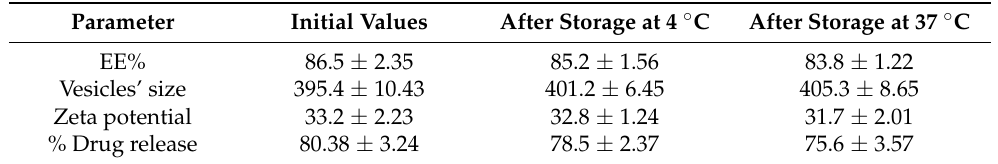
Table 4. Values of EE%, vesicles’ size, zeta potential, and % drug release of the optimized coated BGT-loaded NSPs, initially and after storage for 3 months at 4 ◦ C and 37 ◦